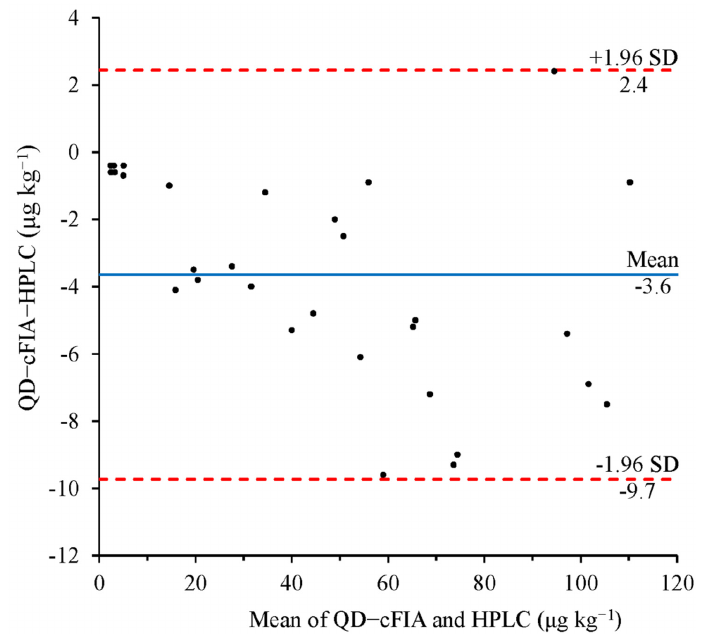
Figure 4. Bland–Altman plots to show comparisons between detection results obtained by the QD-cFIA and HPLC in fortified real